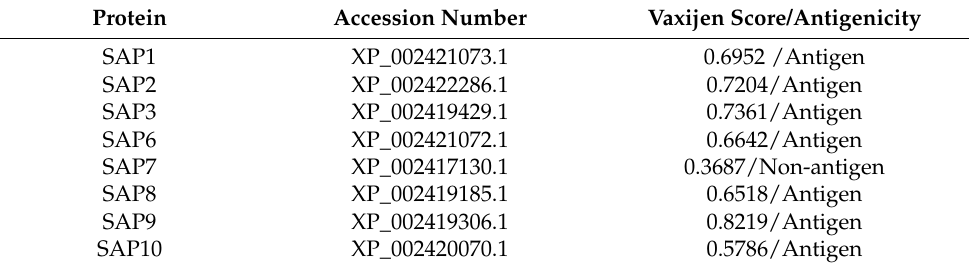
Table 1. C. dubliniensis SAP proteins and their